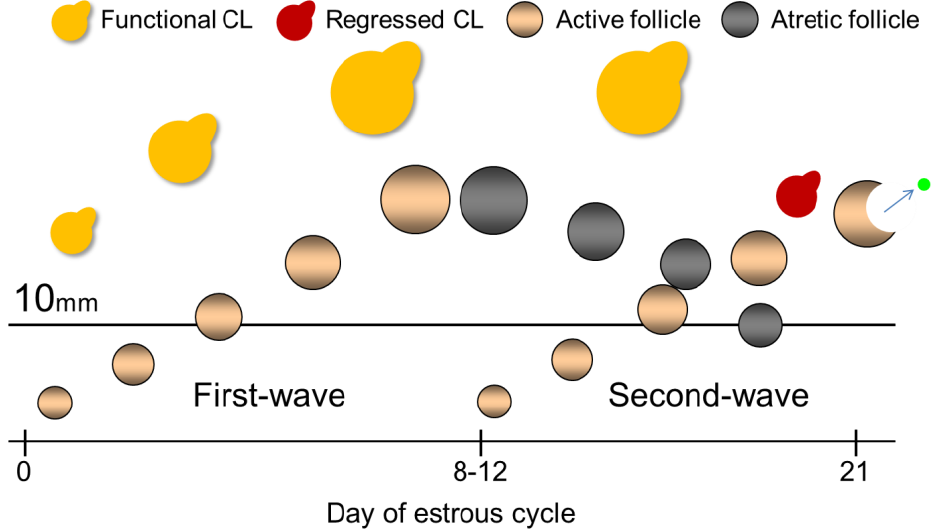
Figure 1. Schematic diagram of the dynamics of ovarian structures (corpus luteum (CL), first-wave dominant follicle (DF), second-wave DF) through the estrous cycle in two-wave pattern cows. The day of estrus is defined as 0 d. It is important to focus on the size of the atretic first-wave DF, which maintains more than 10 mm (a large follicle) during the second-wave DF development during the late estrous cycle.